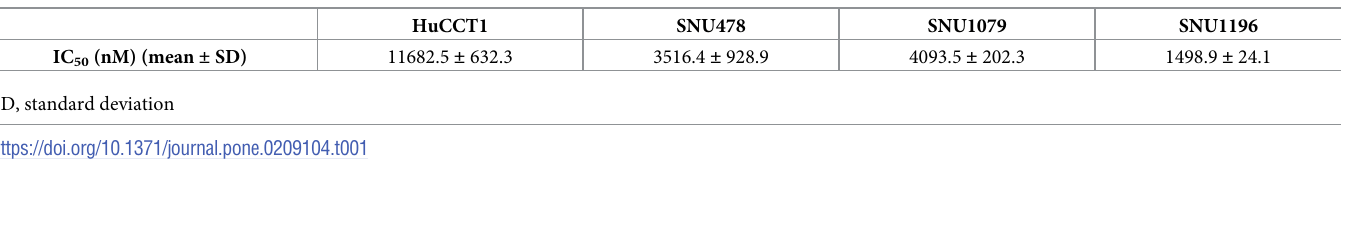
Table 1. Half-maximal inhibitory concentration (IC 50 ) of gemcitabine in four biliary tract cancer (BTC) cell